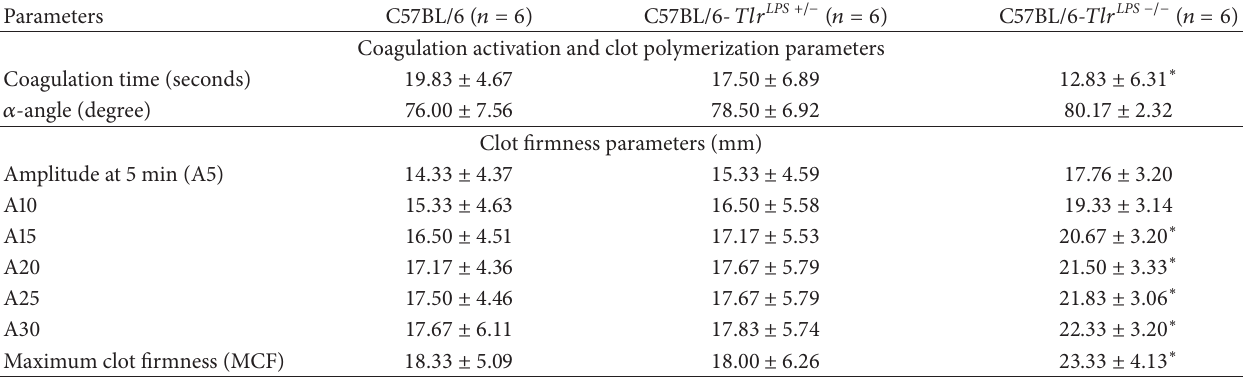
Table 7: ROTEM measurements of FIBTEM in experimental mice.